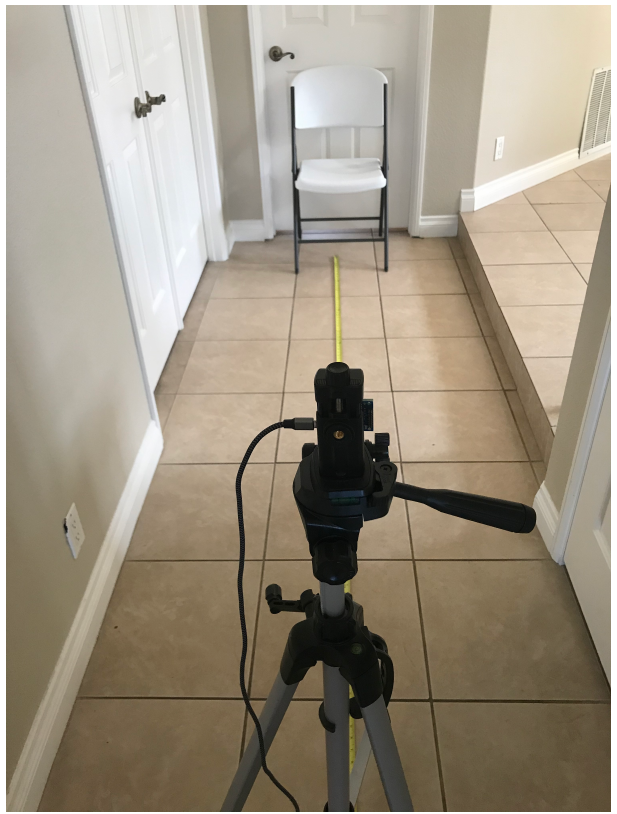
Figure 6. Breathing rate estimation—test